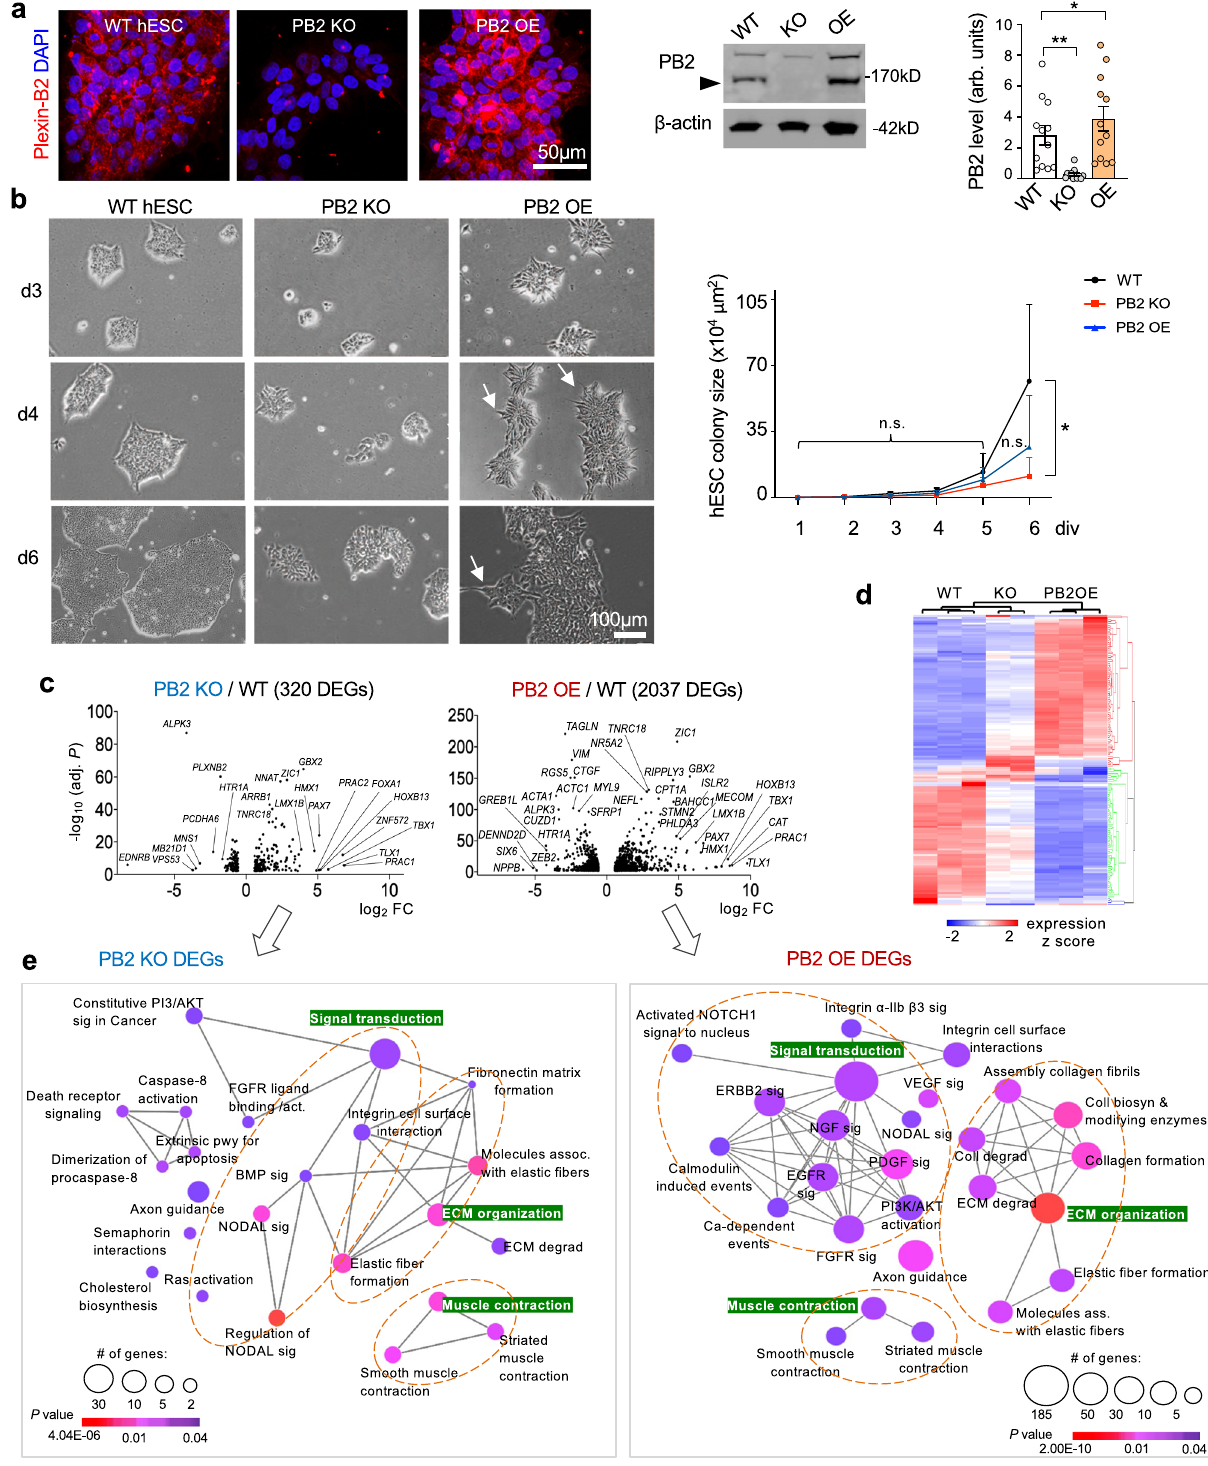
speci fi c DEGs (1765 genes) were enriched for receptor tyrosine kinase (RTK) signaling, including PDGF, EGFR, NGF, VEGF, FGF, and ERBB2 signaling (Fig. S2c). This agrees with the known interactions of Plexins and RTKs 39 . In contrast, Plexin-B2 KO- speci fi c DEGs (48 genes) were enriched for genes related